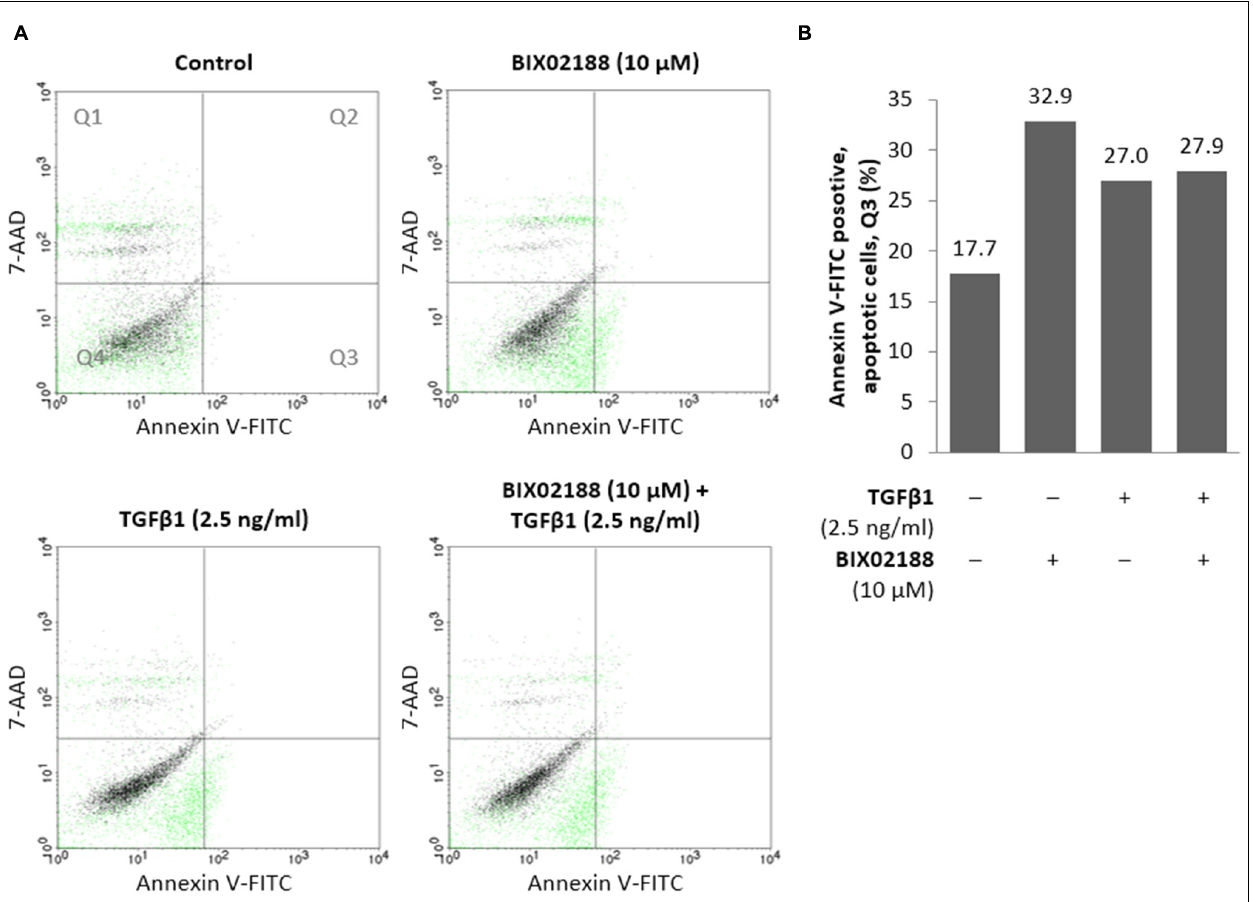
FIGURE 6 | Regulation of podocyte apoptosis via Erk5. (A,B) Flow cytometry analysis of podocytes pre-incubated for 60 min with the Mek5 inhibitor BIX02188 (10 μ M) followed by co-incubation withTGF β 1 (2.5 ng/ml)